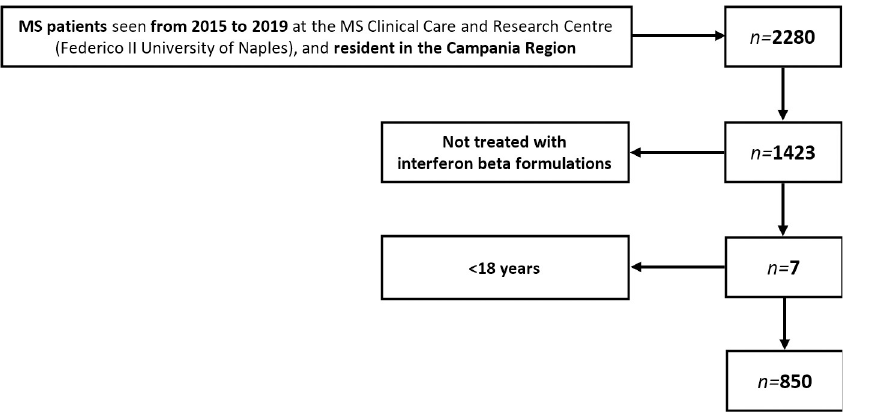
Fig 1. Patient disposition flow